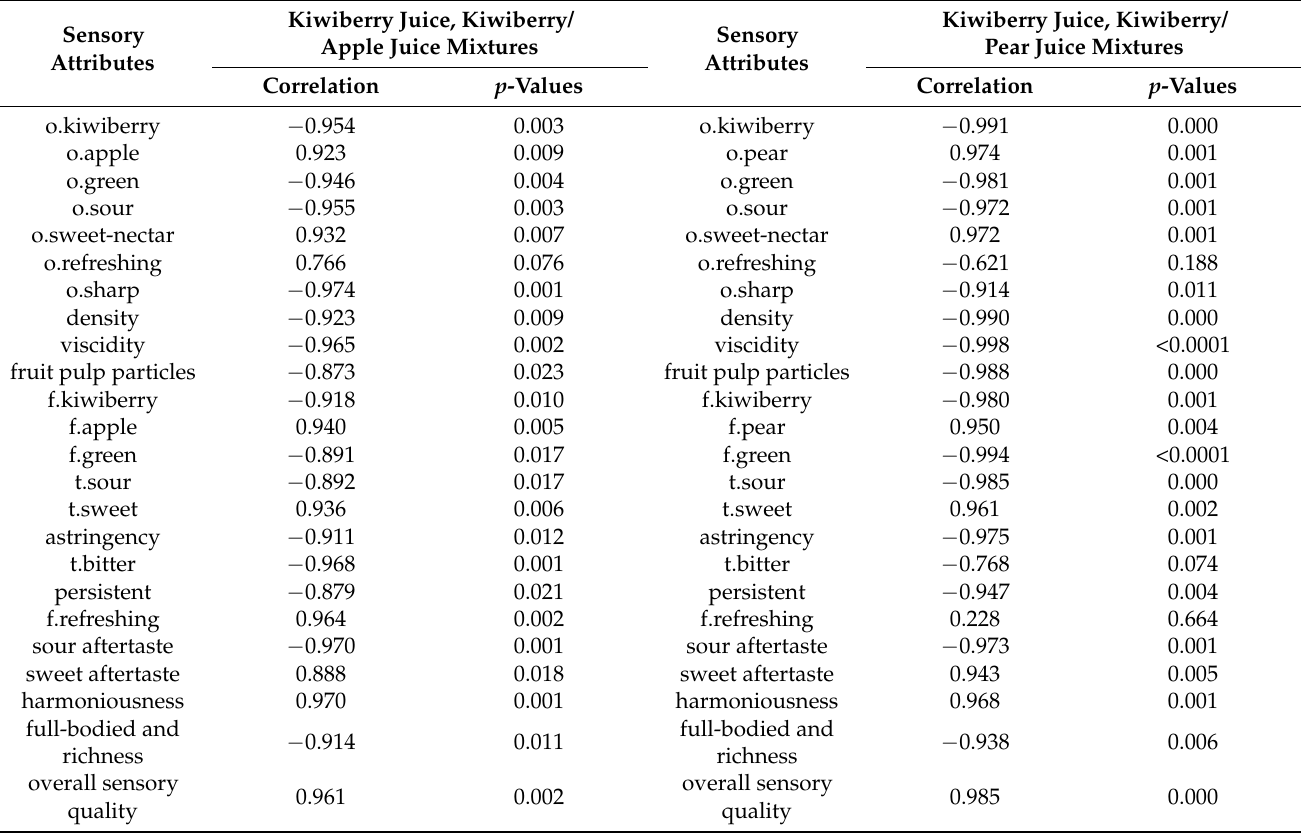
Table 6. Pearson correlation coefficients between sensory attributes and mean hedonic liking of the juices ( n =